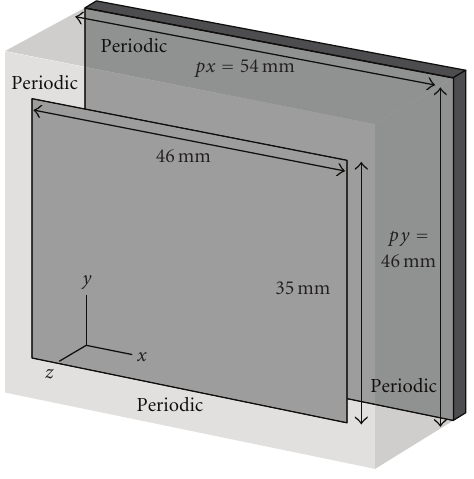
Figure 8: Periodic structure.